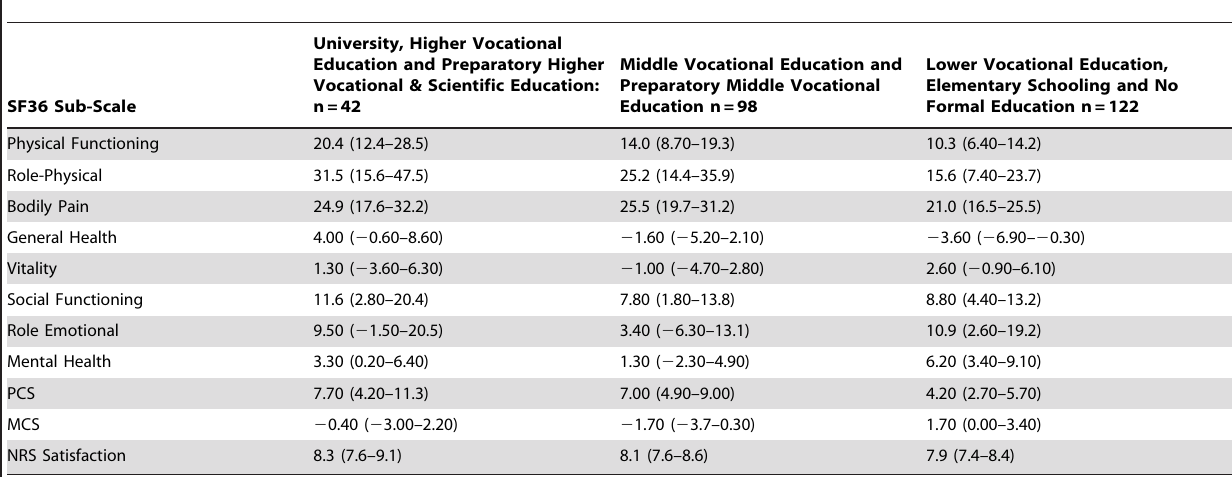
Table 5. Improvement in Health-Related Quality of Life and Satisfaction after Knee Replacement:: A Comparison Between Patients with different Completed Levels of